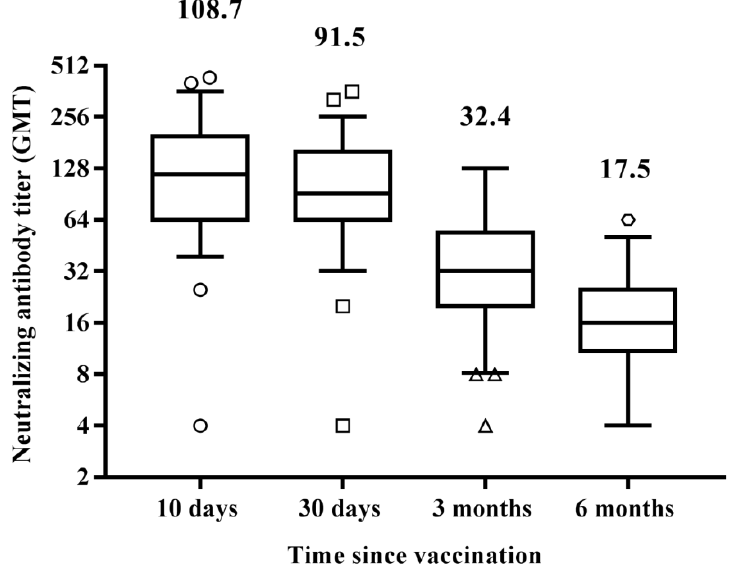
Figure 2. Differences in neutralizing antibody titers (GMT) among the different time samplings after receiving the second vaccine administration. Results are reported in the box-whisker plots as median GMT and upper and lower quartiles. GMT, geometric mean titer. Differences in antibody titers were evaluated, and the statistical significance was assessed using the two-tailed chi-square test. Results were considered statistically significant at p < 0.05. Analyses were performed by using Graph Pad Prism software (v.7.0).